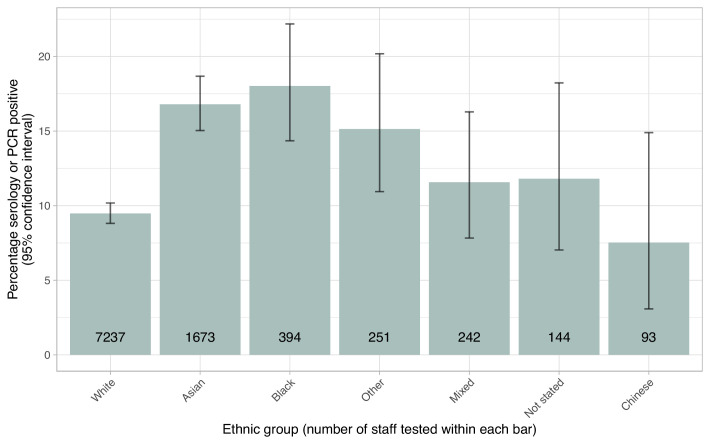
Proportion of staff testing positive by self-described ethnicity.The number of staff tested within each group is shown within each bar. The error bar indicates the 95% confidence interval.